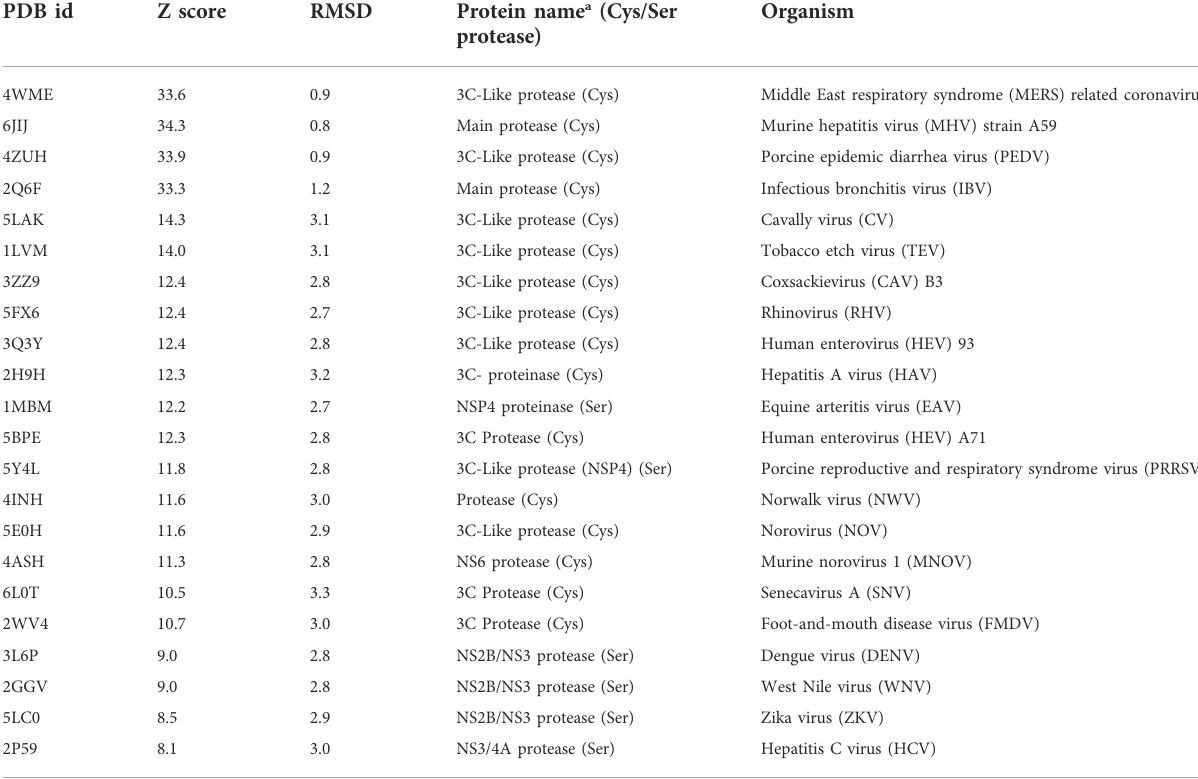
TABLE 1 Viral proteases identi fi ed from DALI